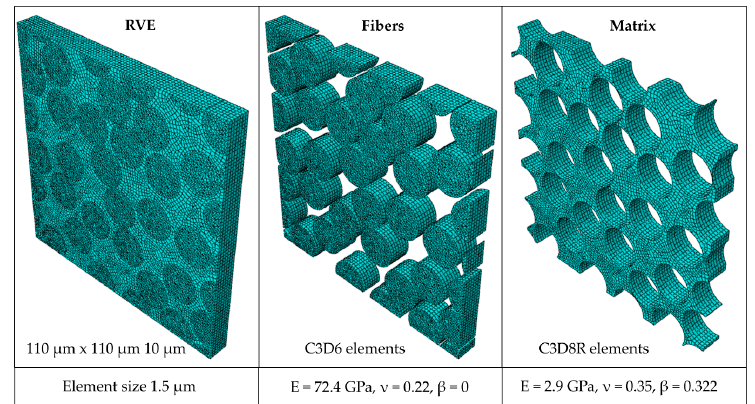
Figure 3. Finite element model of the representative volume element (RVE): fiber and matrix properties are also shown.